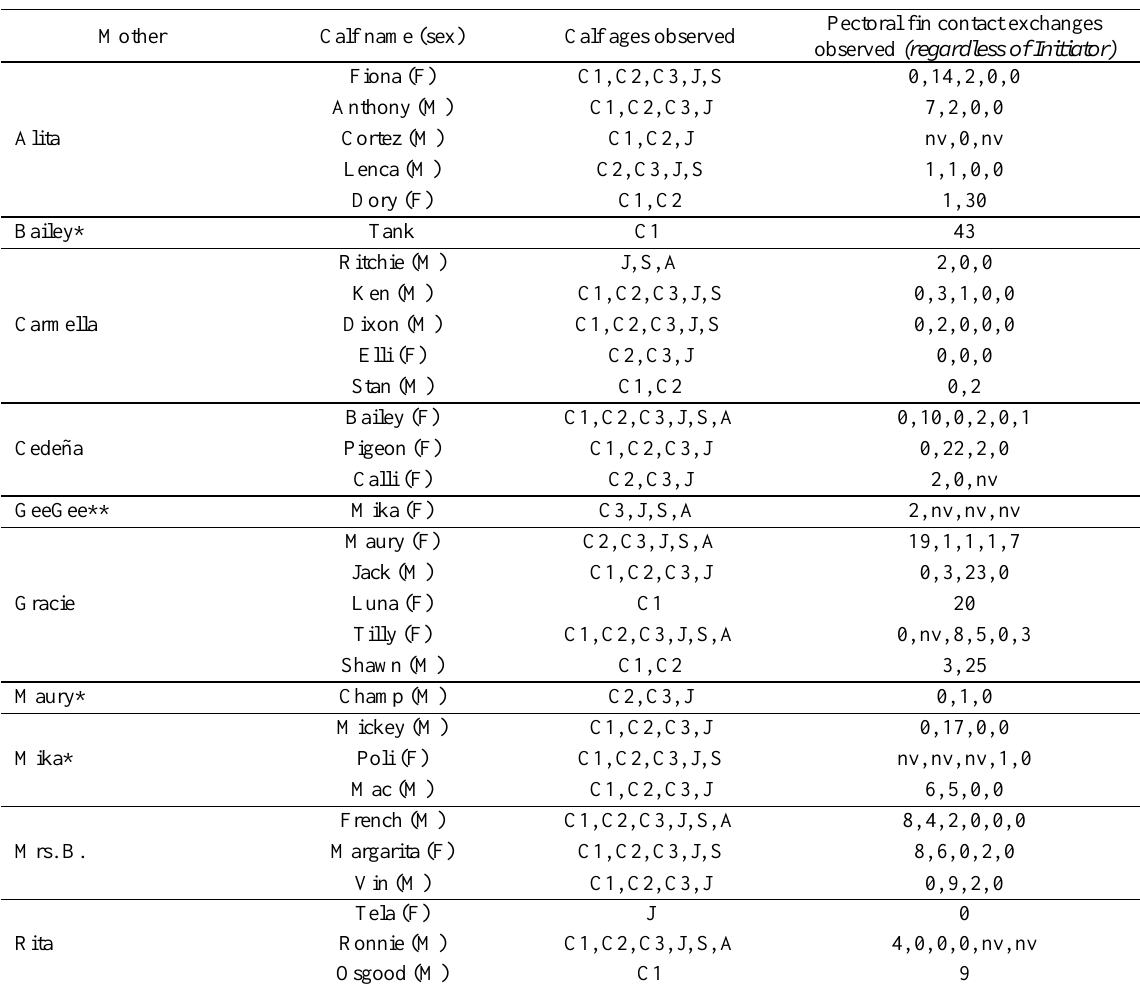
Matrilines with Identified Offspring (calves) Available for Observation Across all Years (2003-2018) and the Number of Documented Pectoral Fin Contact Exchanges for Each Mother/calf Pair Pectoral fin contact exchanges Mother Calf name (sex) Calf ages observed observed (regardless of Initiator) Fiona (F) C1, C2, C3, J, S 0, 14, 2, 0, 0 Anthony (M) C1, C2, C3, J 7, 2, 0, 0 Alita Cortez (M) C1, C2, J nv, 0,